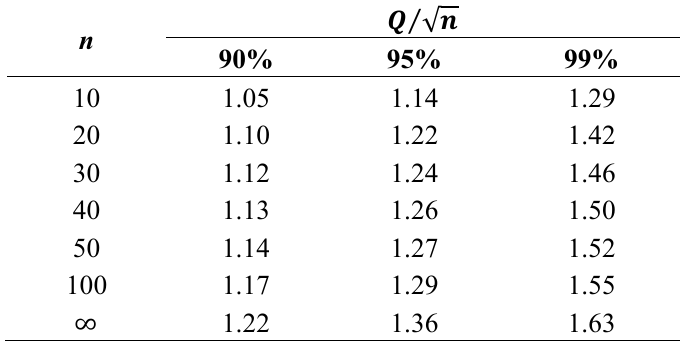
Table 1. Percentage points of (cid:1843) √(cid:1866)⁄